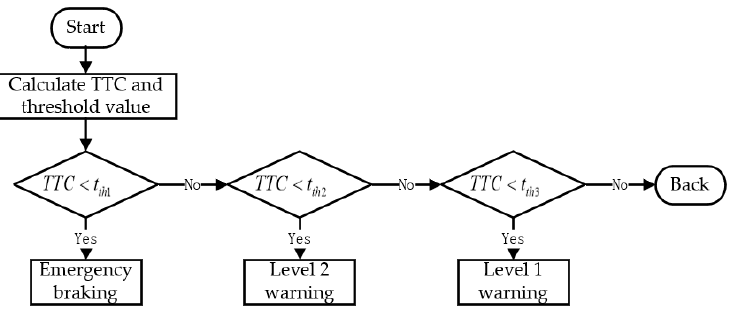
Figure 15. TTC-based AEBS control flow.